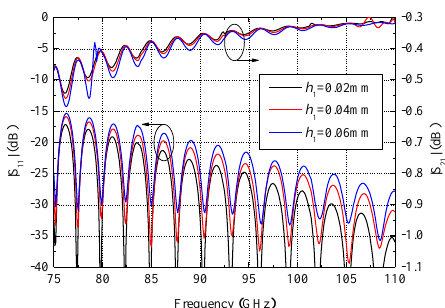
ff erent values of h 1 .